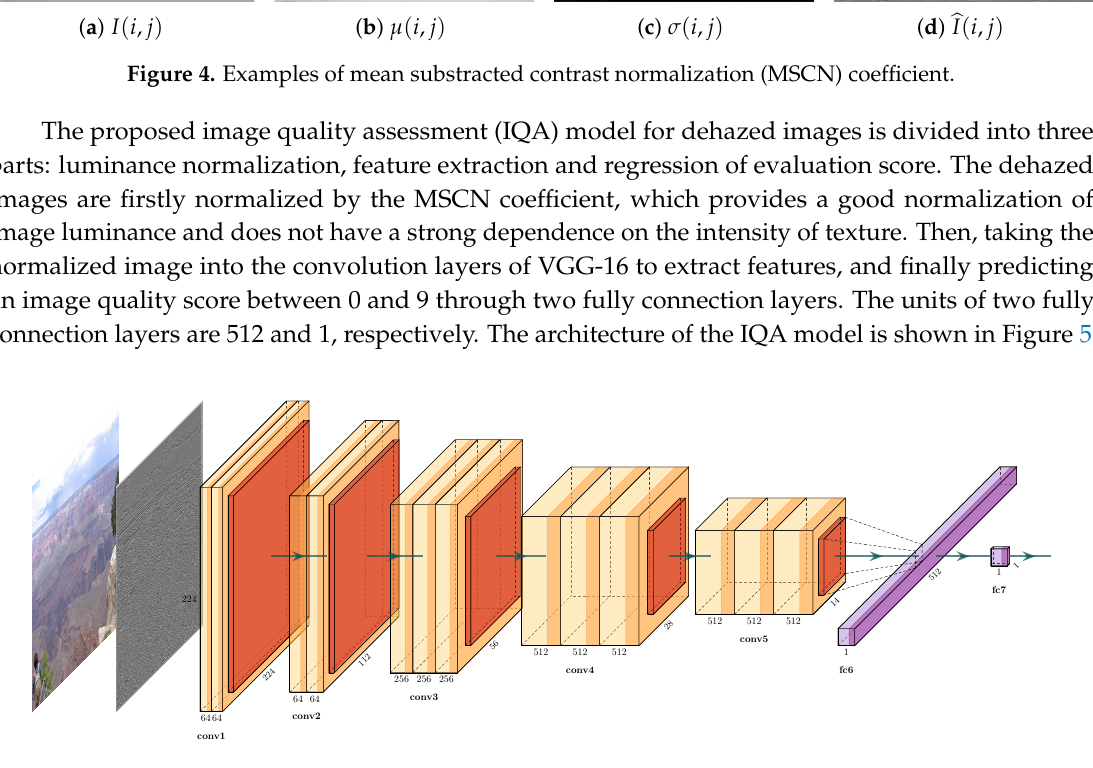
Figure 5. Architecture of the proposed image quality assessment (IQA) model for dehazed